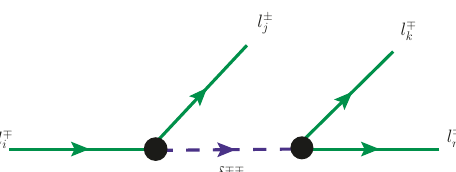
Figure 13. Feynman diagram representing the lepton number and (cid:13)avour violating three body decays of charged lepton: l (cid:7)